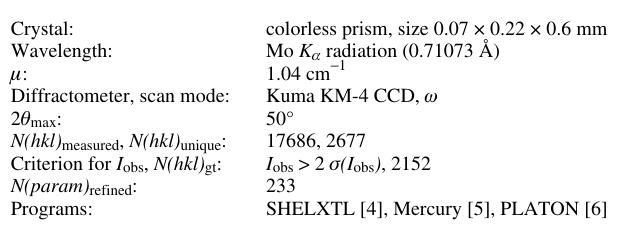
Table 1. Data collection and handling.